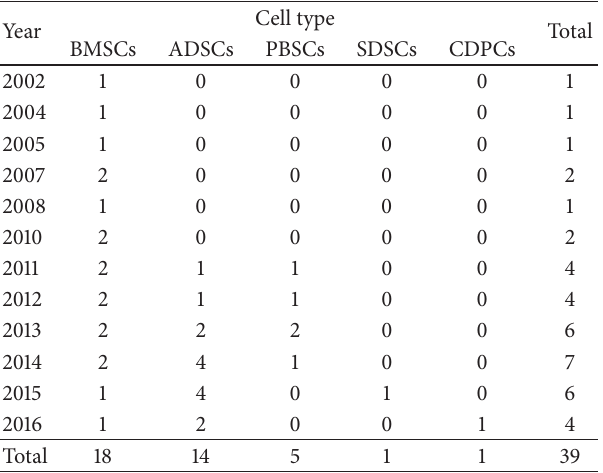
Table 2: Types of stem cells used clinically for cartilage regeneration past and present. This table shows the PubMed database search results for clinical trials involving stem cells in cartilage regenera- tion, published from 2000 until the end of June 2016 (number of